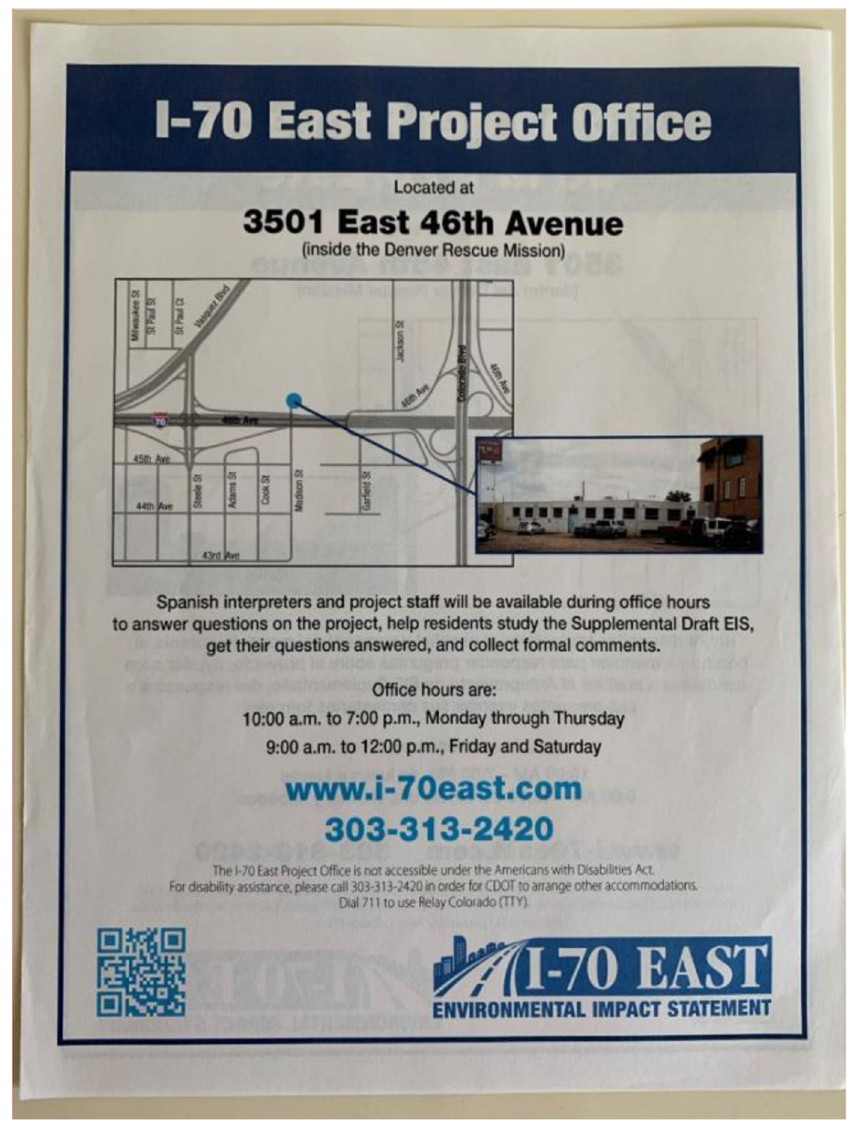
Fig. 8 Globeville ’ s personal communication (source: author ’ s